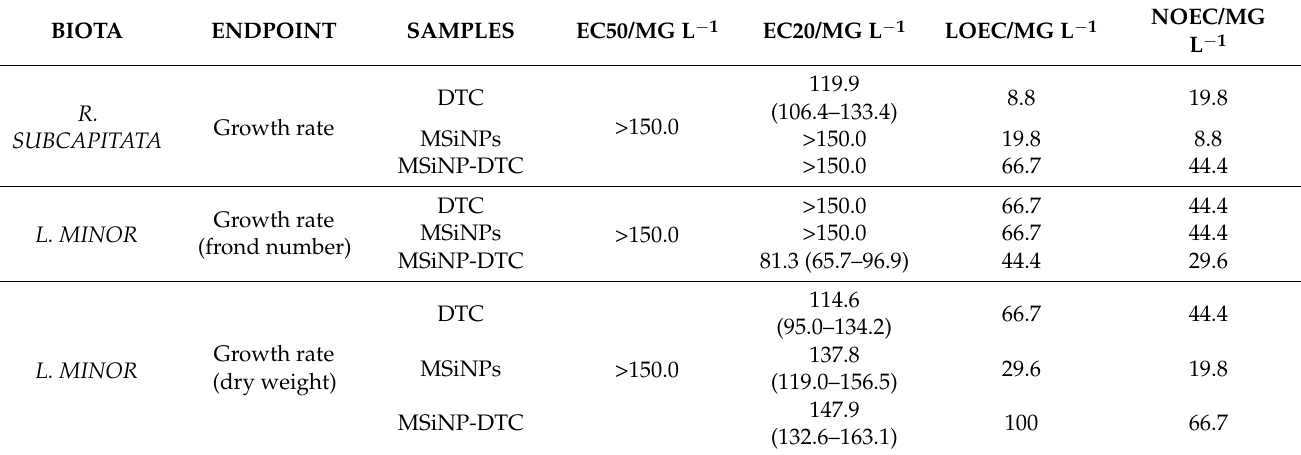
Table 3. Effective concentrations (EC 50 /EC 20 ), LOEC, and NOEC in mg L − 1 of DTC, MSiNPs,